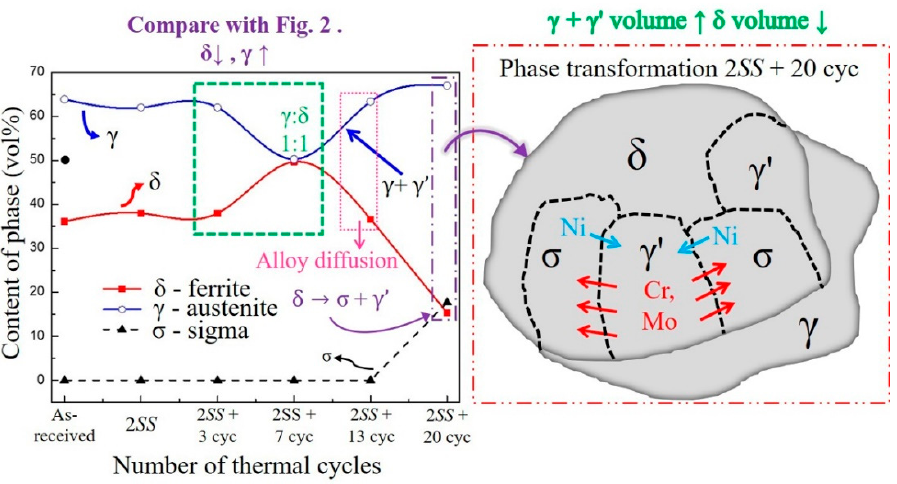
Figure 3. Analysis of X-ray diffraction patterns for various thermal cycling processes.